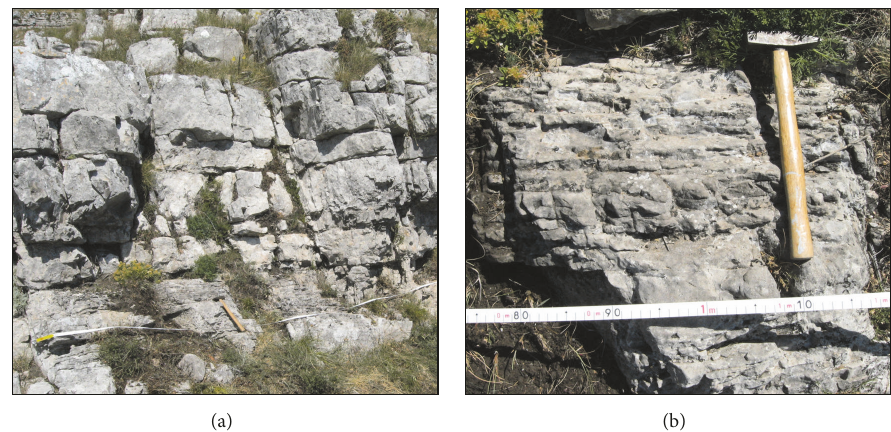
Figure 4: Field photographs showing (a) the outcrop analysed through the scan line method and (b) the C2-6 bed.